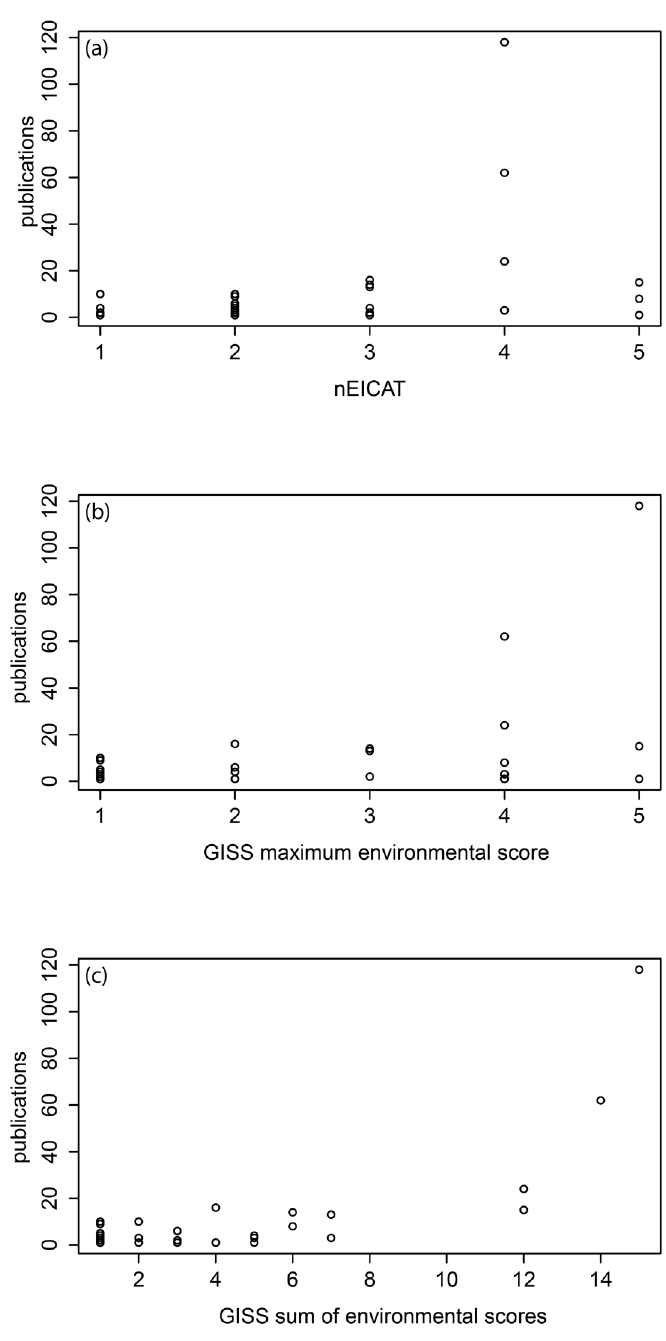
Figure 2. The relationship between the number of publications with data that can be used to assess impact for a species of alien amphibian and a its EICAT score b its GISS score and c the sum of envi- ronmental